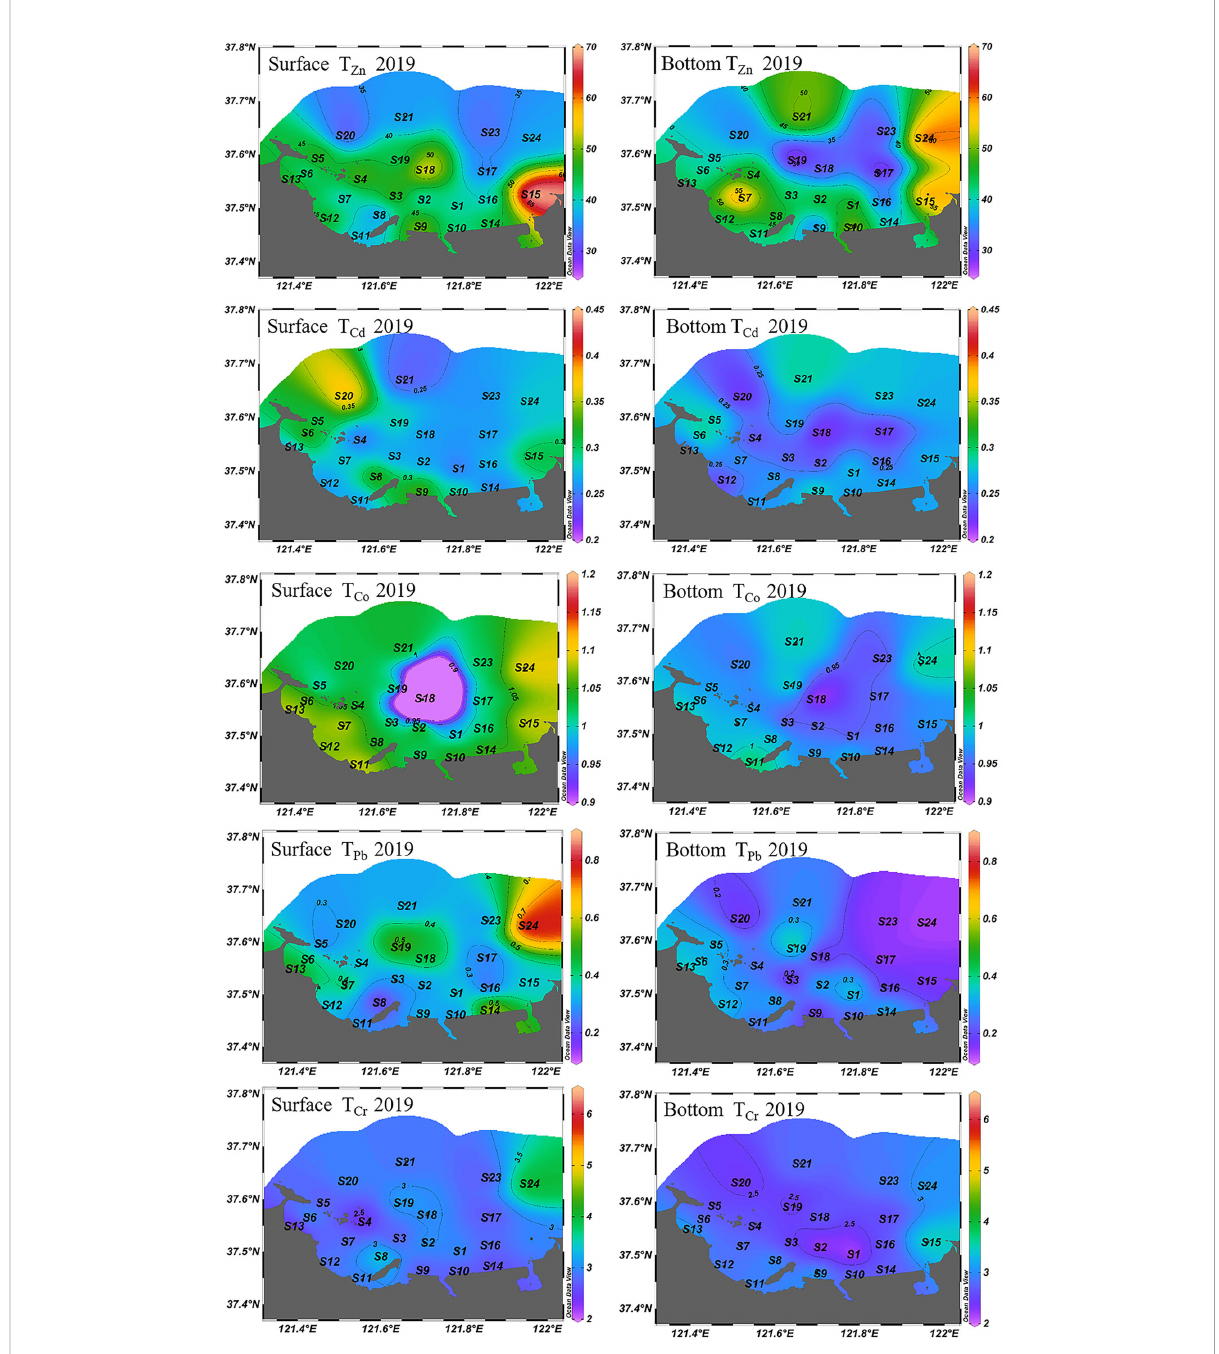
FIGURE 3 Spatial distribution of Zn, Cd, Co, Pb, and Cr (unit: m g/L) in the YOA in August 2019 for surface seawater and bottom